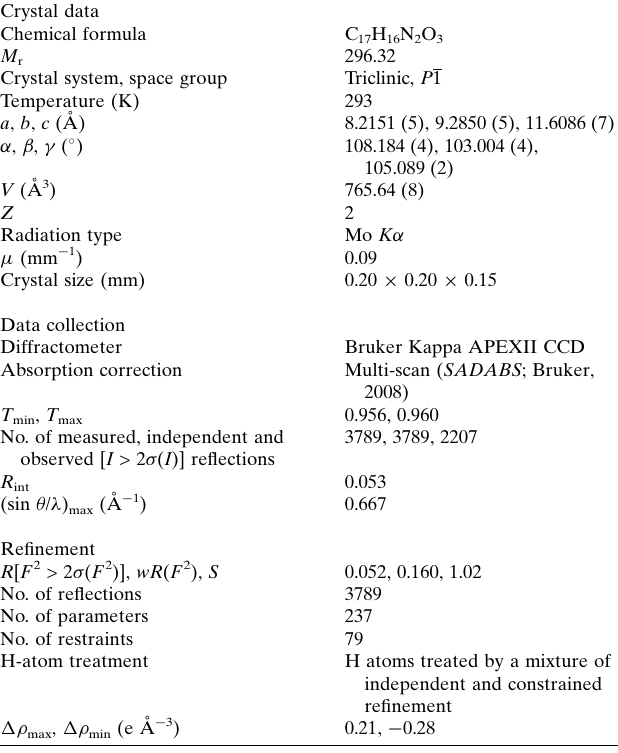
Table 2 Experimental details. Crystal data Chemical formula